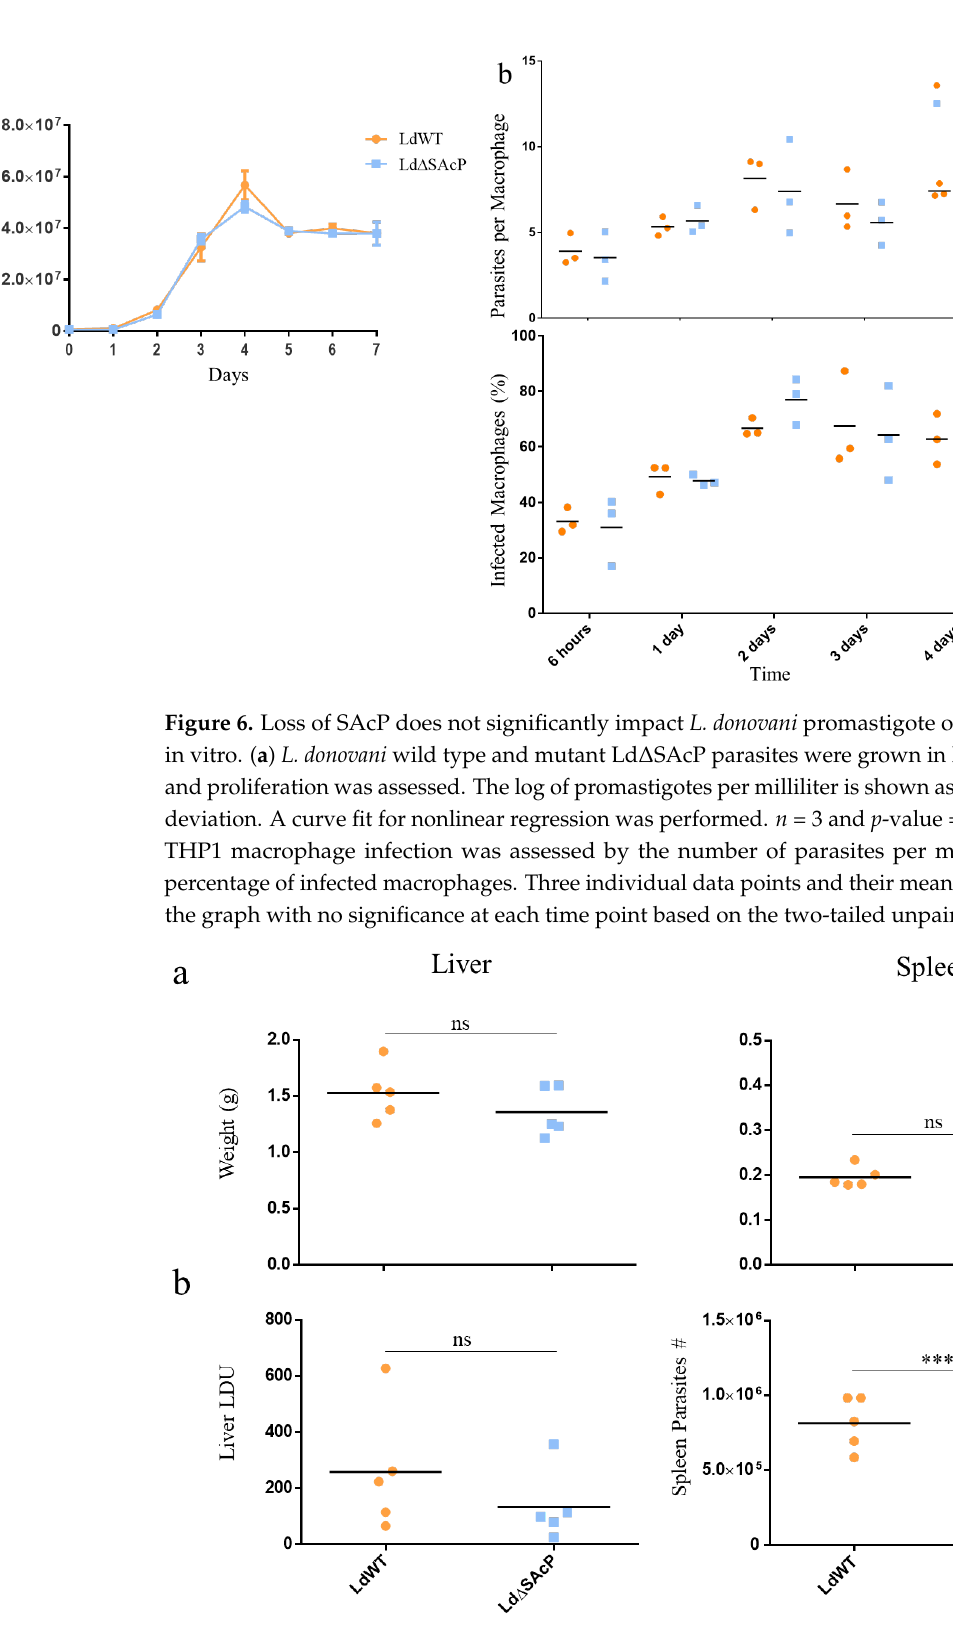
Figure 7. Comparison of LdWT and Ld ∆ SAcP parasites in a mouse model. BALB/c mice were infected with 1 × 10 8 parasites (LdWT = orange and Ld ∆ SAcP = blue) via teil vein infection.